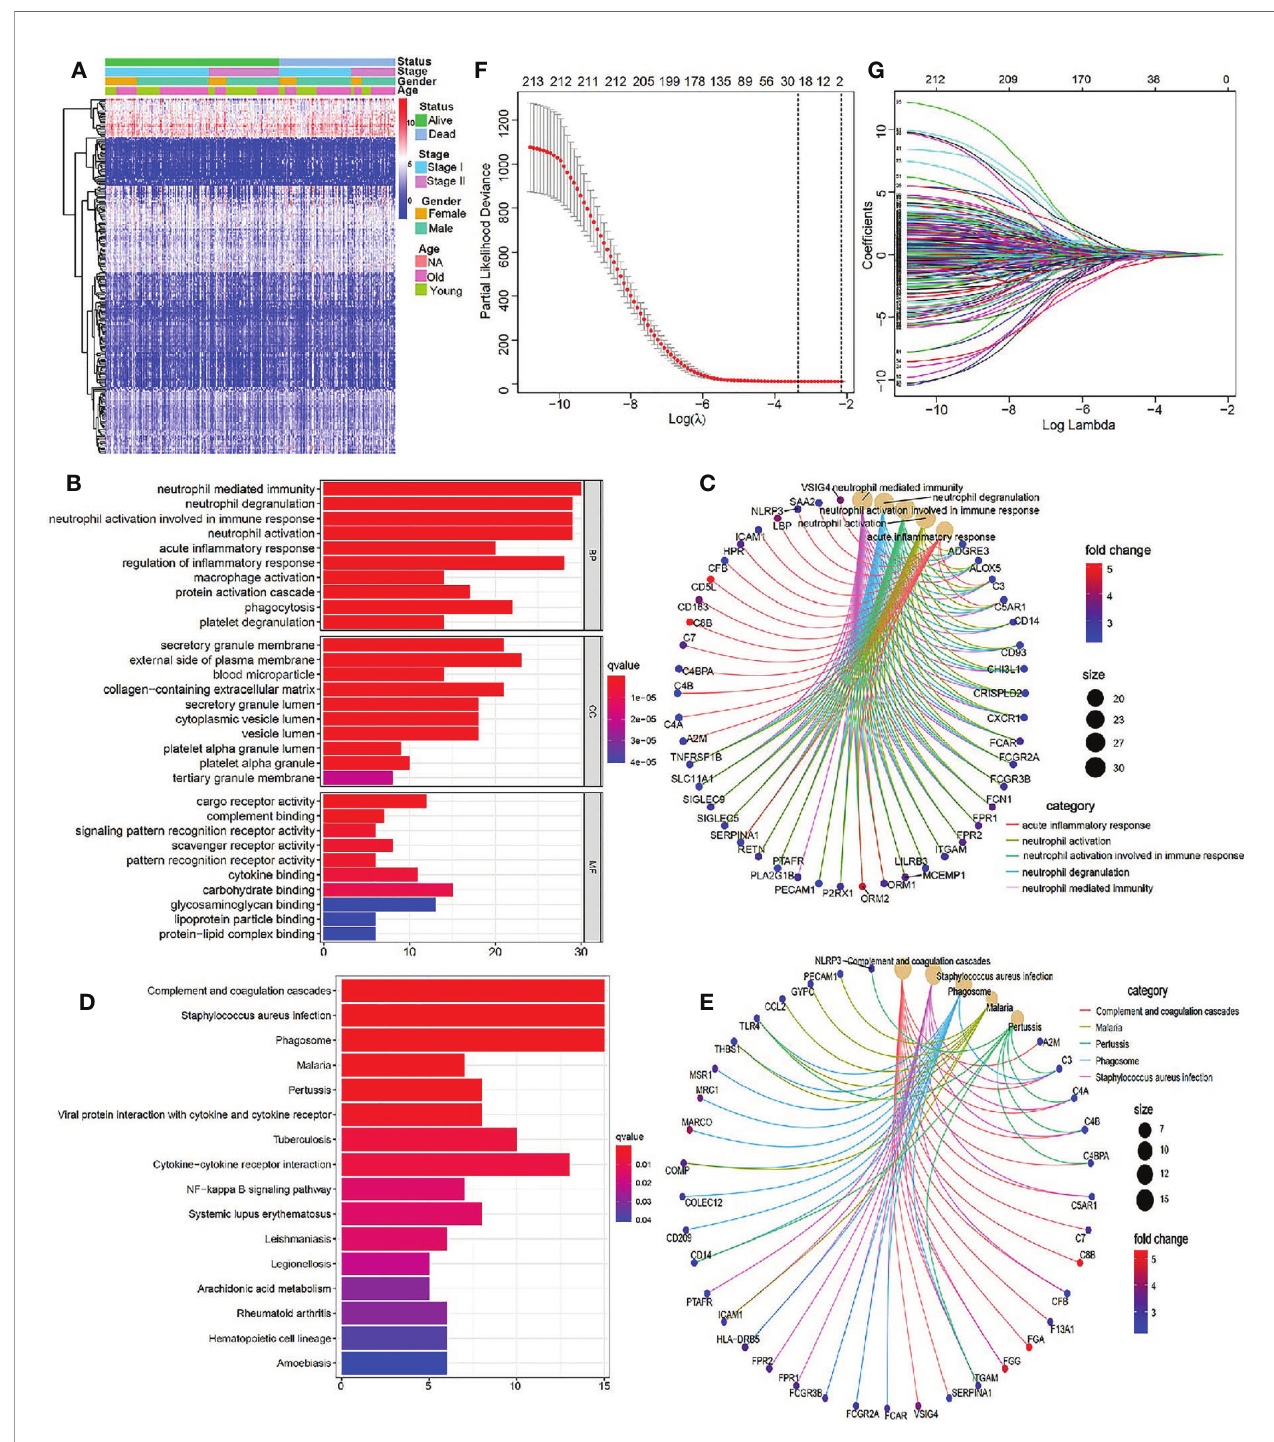
FIGURE 2 | Identi fi cation of core prognostic differentially expressed immune-related genes. (A) Heatmap showing gene expression value across each sample, and the distribution of status by patient gender, TNM stage and age. (B, C) GO analysis of the core prognostic differentially expressed immune-related genes. (D, E) KEGG analysis of the identi fi ed prognostic genes. (F) LASSO model selecting most useful parameter. (G) LASSO coef fi cient graph of the key prognostic immune-related